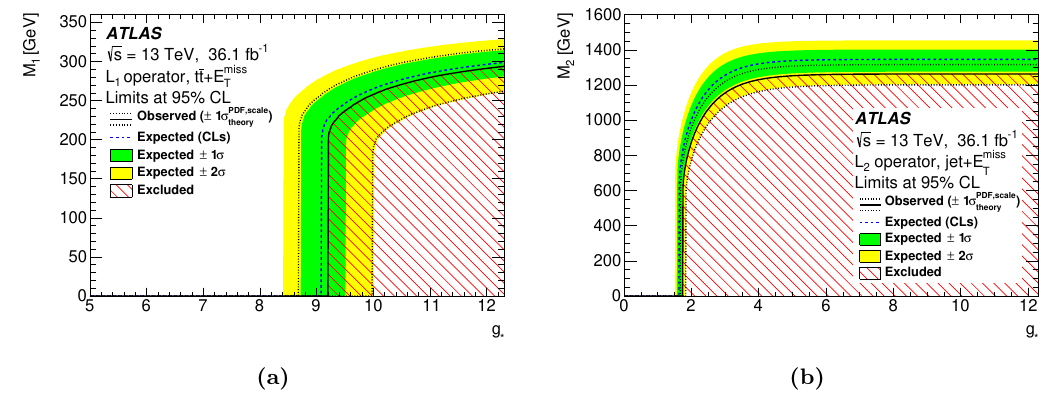
Figure 22. Exclusion plots for (a) account the EFT validity criterion